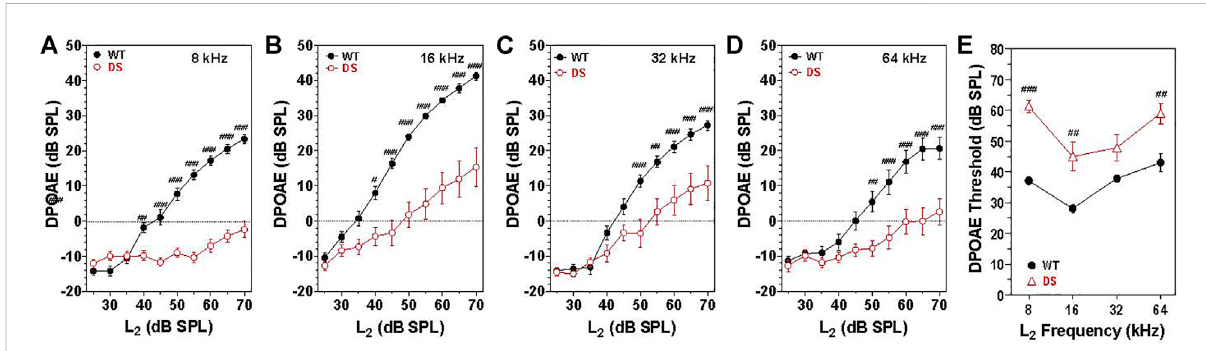
FIGURE 3 DPOAE amplitudes signi fi cantly less in DS mice ( n = 15) compared to WT mice ( n = 15). Mean (+/-SEM) DPOAE input/output functions. AmplitudeplottedasafunctionofL2intensityatF2frequenciesof (A) 8, (B) 16, (C) 32,and (D) 64 kHz. (E) DPOAEthresholdssigni fi cantlygreaterinDS mice versus WT mice. DPOAE threshold versus frequency ( n = 15, +/ − SEM). # p < 0.05; ## p < 0.01; ### p <